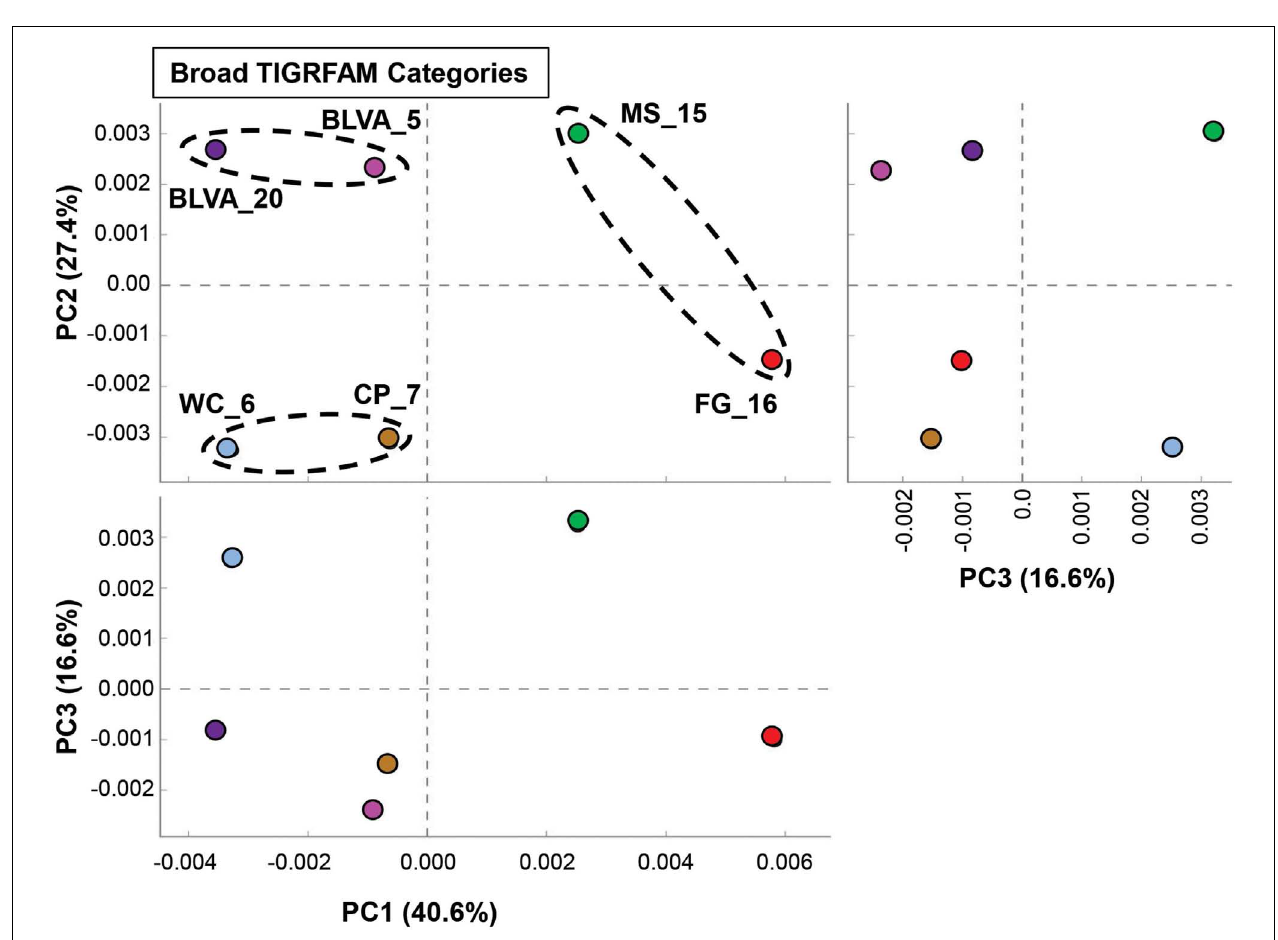
Appendix for hierarchal cluster analysis). Site-pairs are circled based on separation achieved with PC1 and/or PC2 (BLVA_5 =